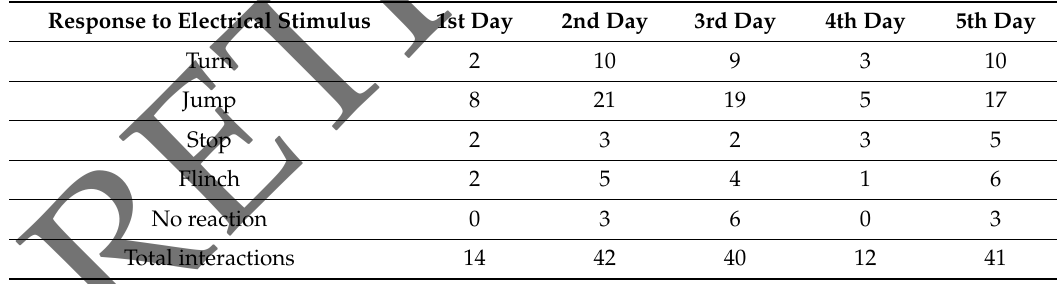
Table 6. Contingency table of the number of times the electrical stimulus was or was not applied to the goat, following an audio cue during the stimuli